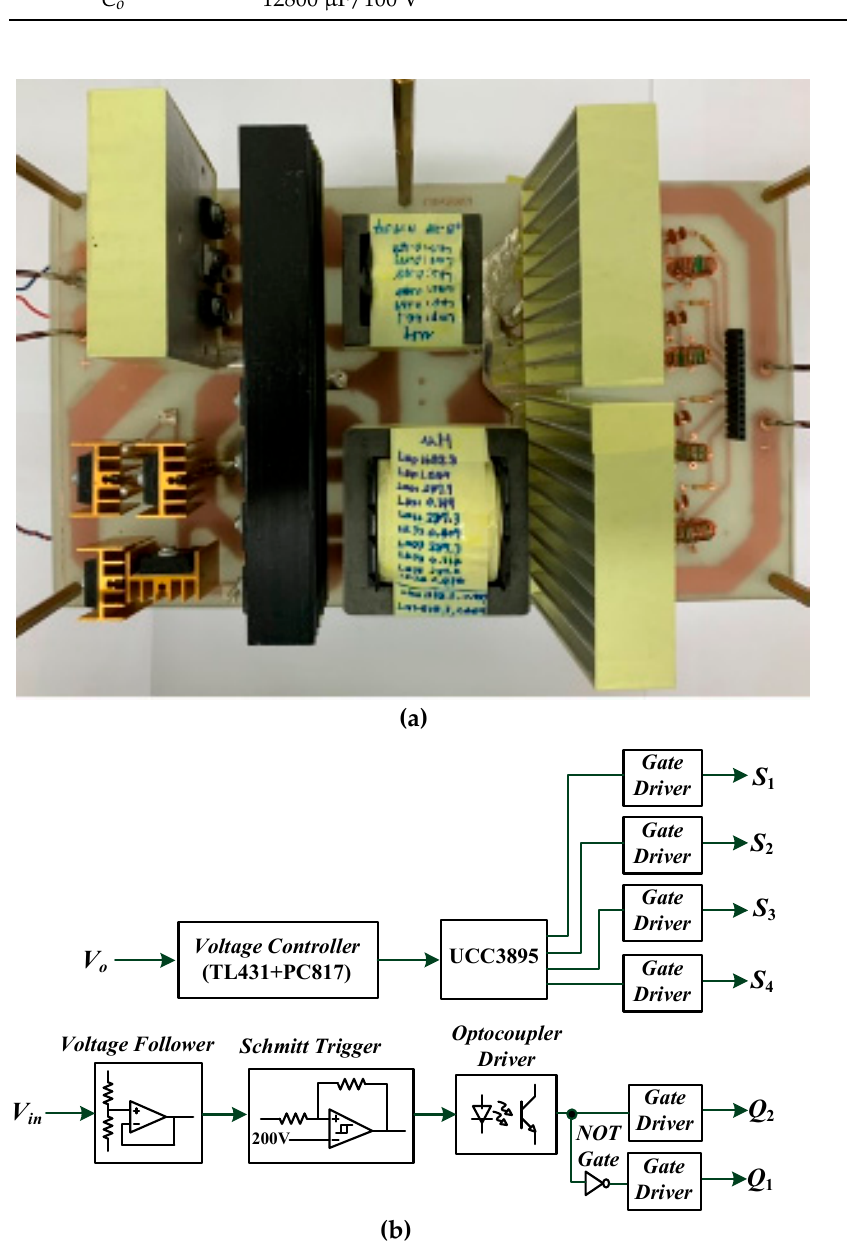
Figure 5. Prototype circuit ( a ) picture of the proposed converter ( b ) control blocks.